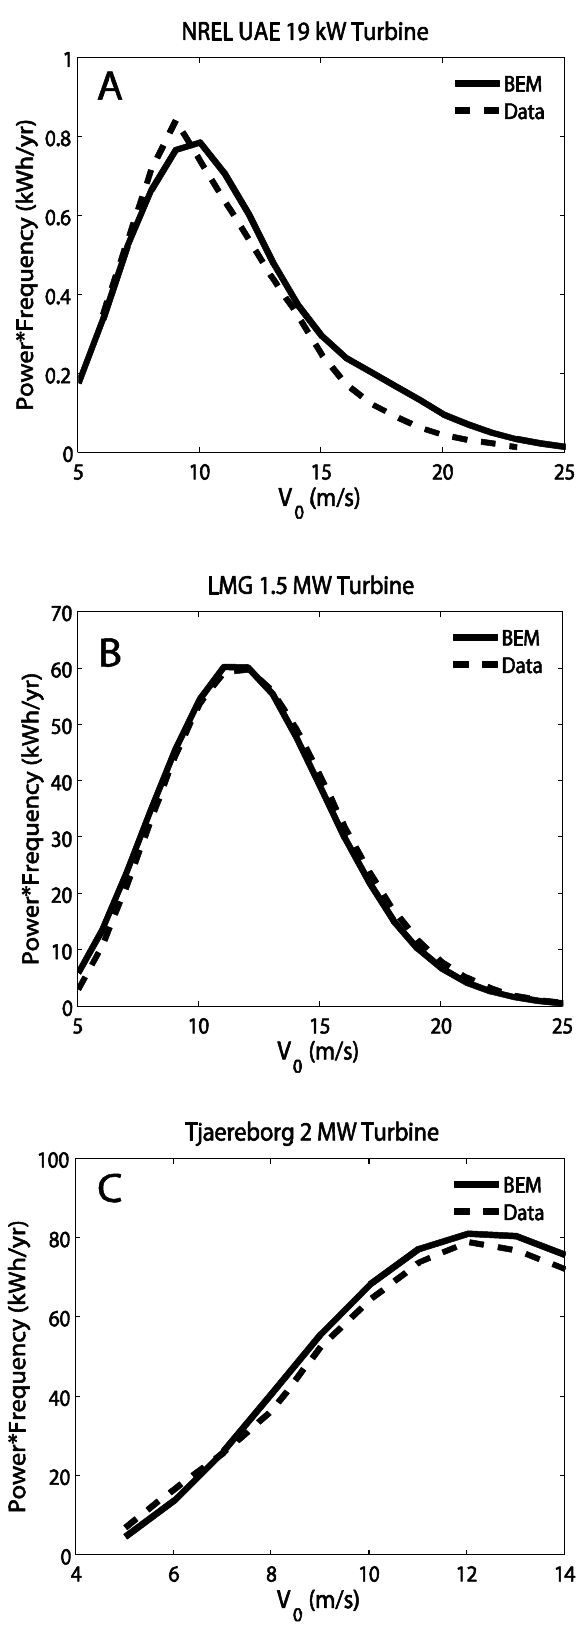
Figure 6. Previous power comparisons weighted with the Rayleigh probability distribution: (A) NREL vs. model, (B) LMG vs model, and (C) Tjaereborg vs